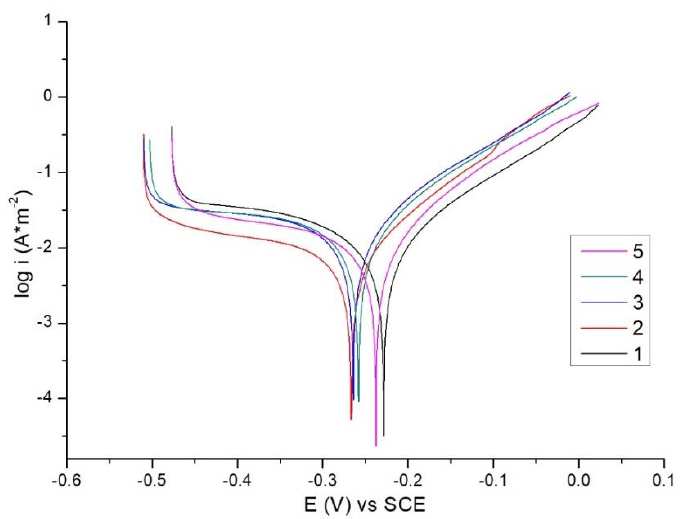
Figure 9. Potentiodynamic polarization curves for laser cladded NiCrBSi coatings in 3.5% NaCl solution at 22 °C.